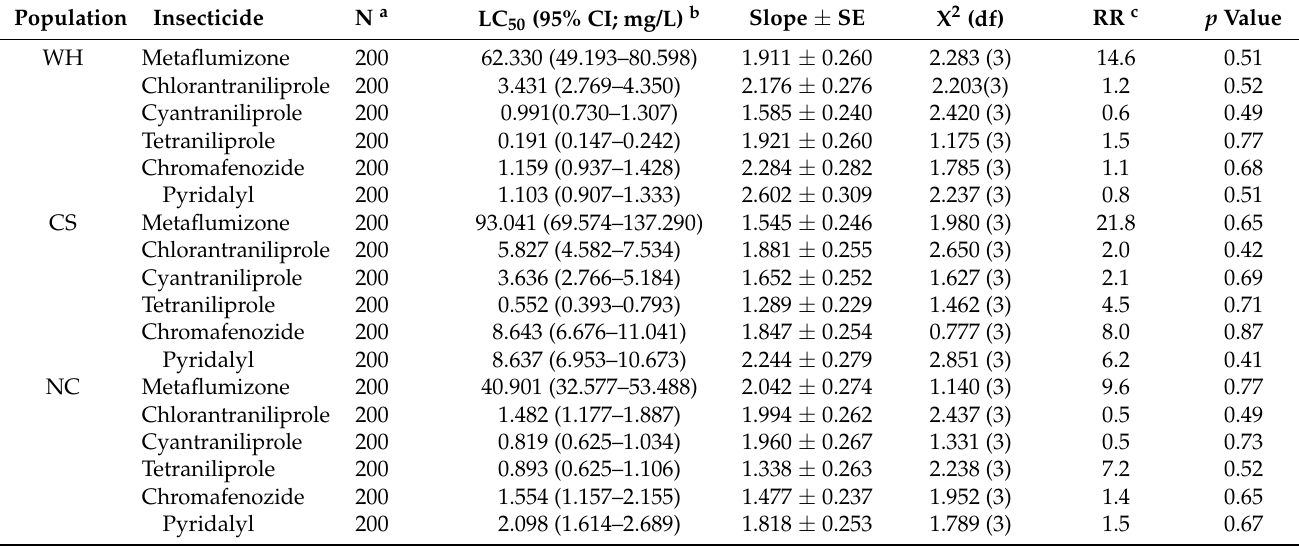
Table 4. Insecticide susceptibility of S. litura collected from central